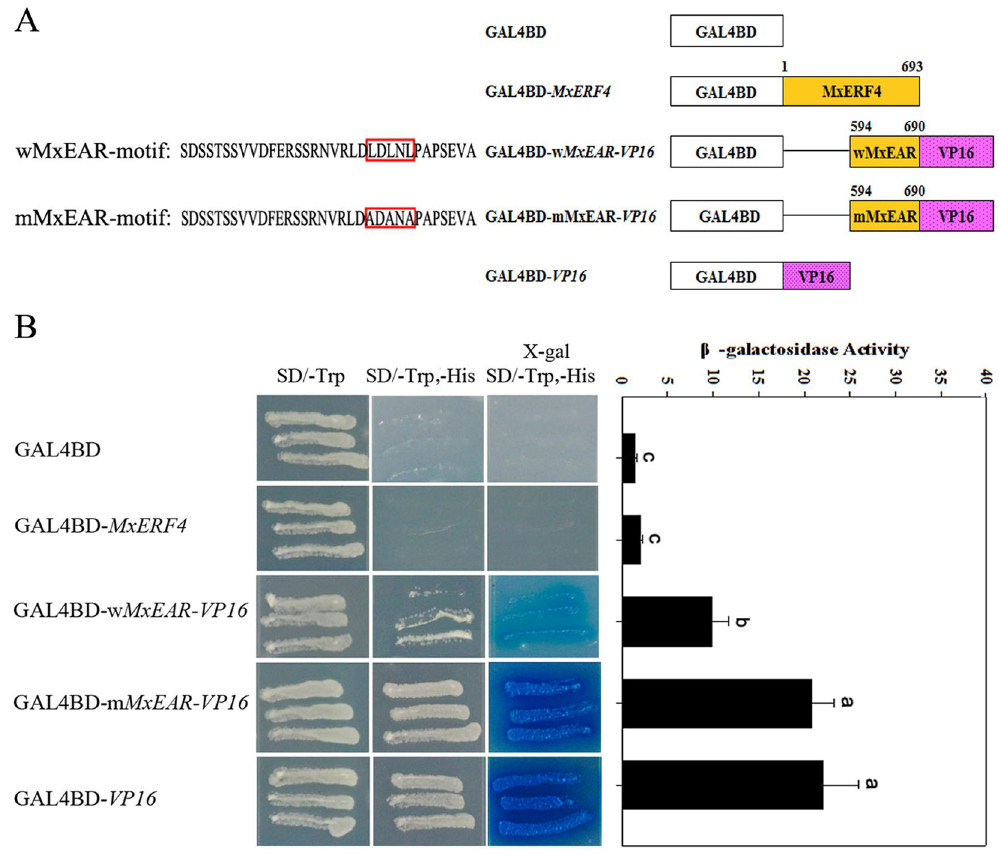
Figure 4. The MxERF4 EAR repression domain inhibits transcriptional activity. ( A ) The EAR-motif point mutation structure diagram of MxERF4 wEAR-motif (LDLNL) mutated as mEAR-motif (ADANA). (B) Analysis of X-gal assay of MxERF4 in yeast to identify transactivation activity and β -galactosidase activity. Growth status of yeast AH109 harboring MxERF4 full length (GAL4BD- MxERF4 ), carrying MxERF4 EAR motif of VP16 (GAL4BD- wMxEAR-VP16 ), MxERF4 EAR motif point mutation of VP16 (GAL4BD- mMxEAR-VP16 ) and VP16 (GAL4BD -VP16 ) on minimal medium/-Trp and minimal medium/-Trp,-His, pBD-GAL4 Cam vector (GAL4BD) as control; Transactivation activity by an X-gal assay on minimal medium/-Trp,-His. Values are the means ± SE (n =